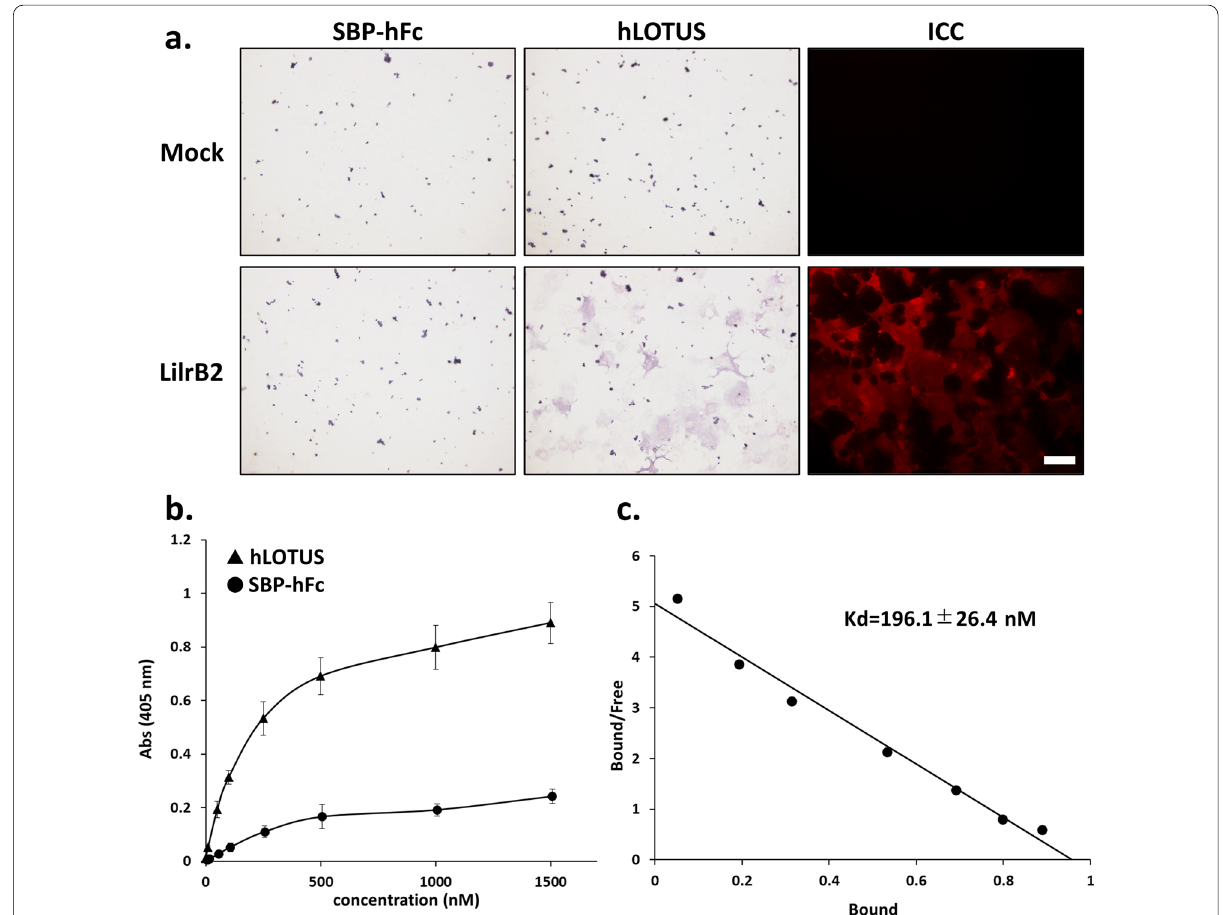
Fig. 4 Binding ability human soluble LOTUS and LilrB2. a Representative images of the binding assay using soluble human LOTUS protein (LOTUS-Fc-SBP, 500 nM) in LilrB2-overexpressing Cos7 cells and immunocytochemistry with the antibody against LilrB2. Scale bars, 100 μm. b , c Saturation curves ( b ) and scattered analysis ( c ) of binding control protein or soluble human LOTUS to LilrB2 overexpressed in Cos7 cells. The data are presented as mean SEM from three independent cell culture preparations (n ±